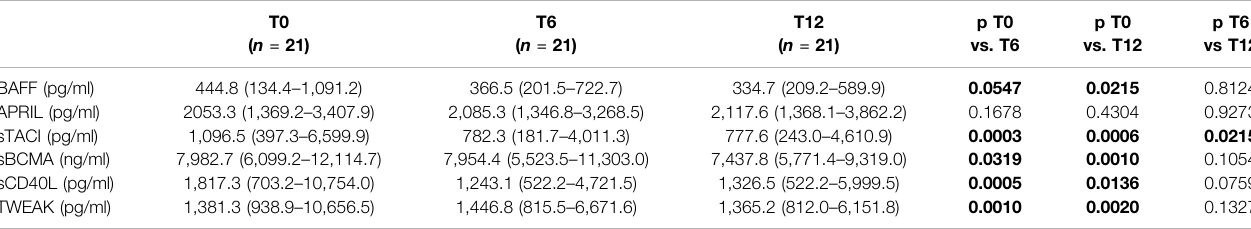
TABLE 3 | Serum Levels Changes of TNF related Biomarkers during belimumab